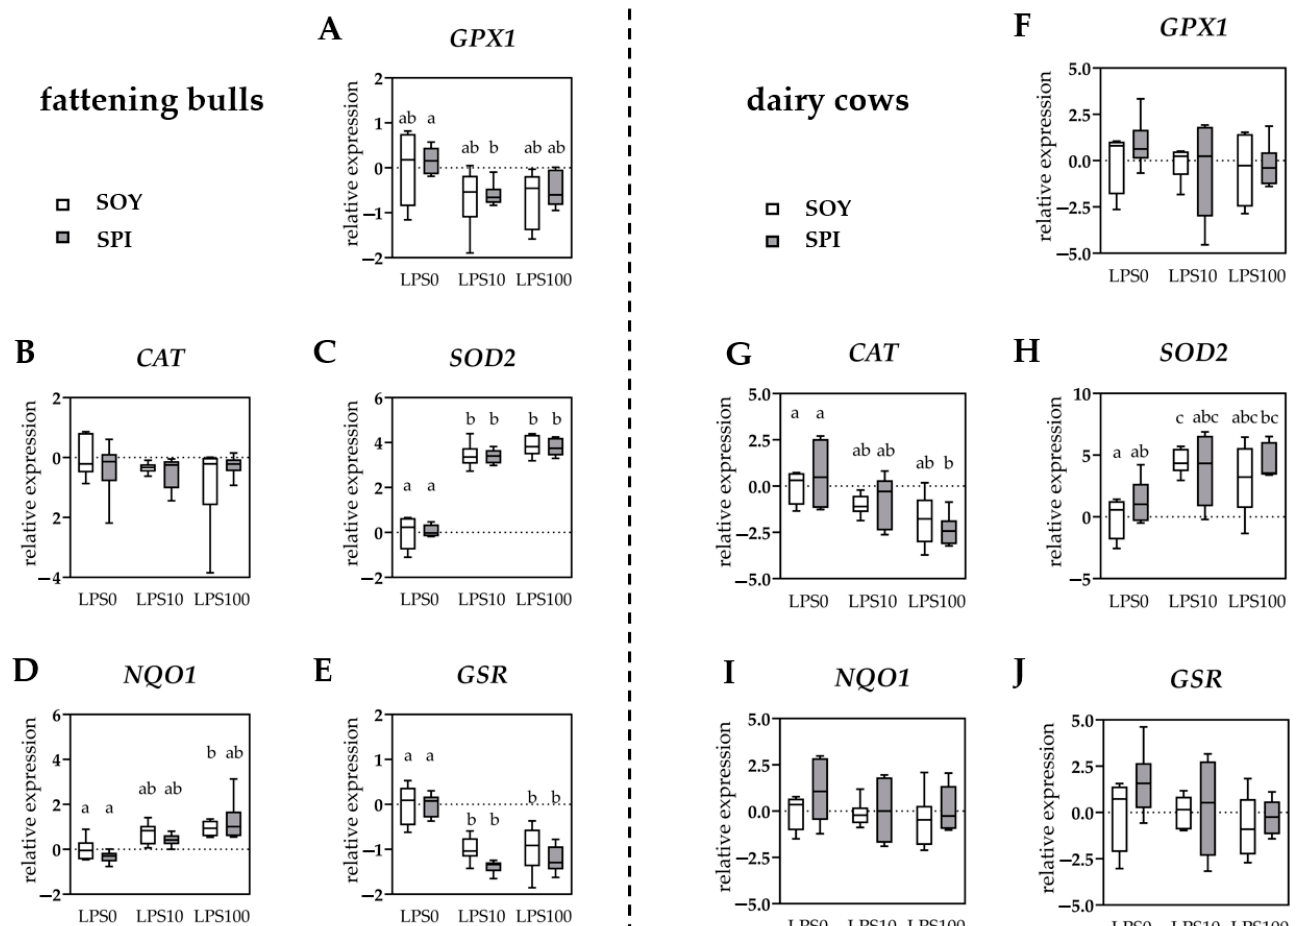
Figure 2. Relative expression of antioxidant genes in peripheral blood mononuclear cells isolated from fattening bulls ( A – E ) and dairy cows ( F – J ) fed with soybean meal (white boxes) or spirulina (gray boxes) as protein source. Individual results were normalized to the mean of the respective SOY LPS0 group. Results are presented in boxplots with Spear style whiskers (min to max). Different lowercase letters indicate significant differences ( p ≤ 0.05).